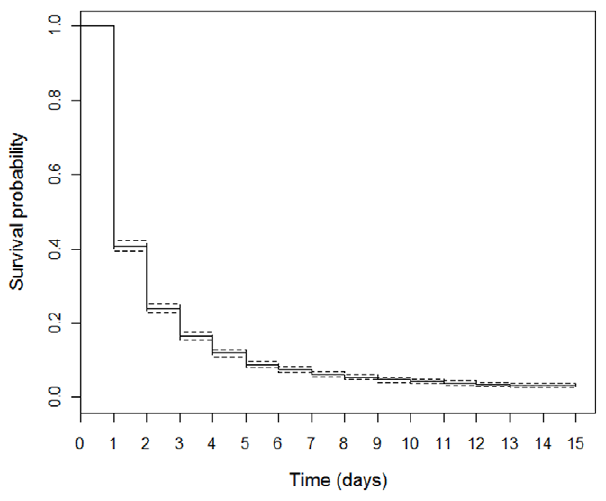
Figure 1. Overall survival curve for the ‘‘all taxa ’’ data set (Kaplan-Meier estimate and corresponding 95% confidence intervals; N=4447; the length of time axis is limited to a maximum of 15 days).